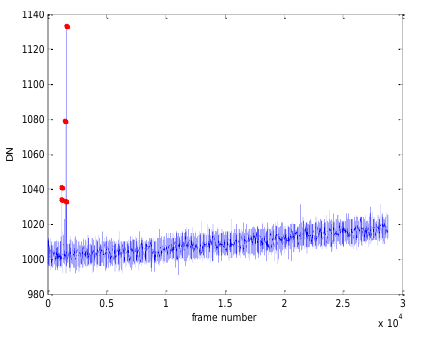
Figure10. Energy spectrum of daytime lightning